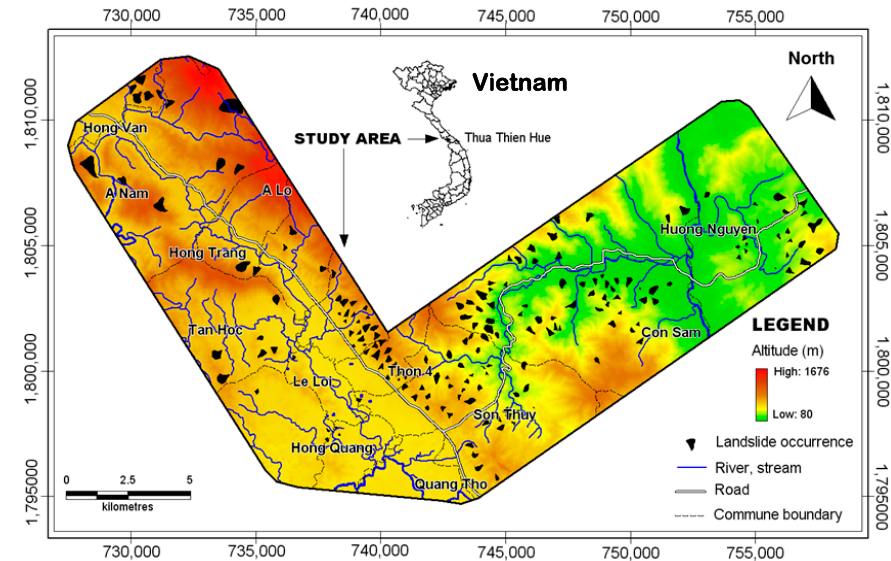
Figure 1. Location of the study area in the district of A Luoi, Thua Thien Hue Province, Vietnam.